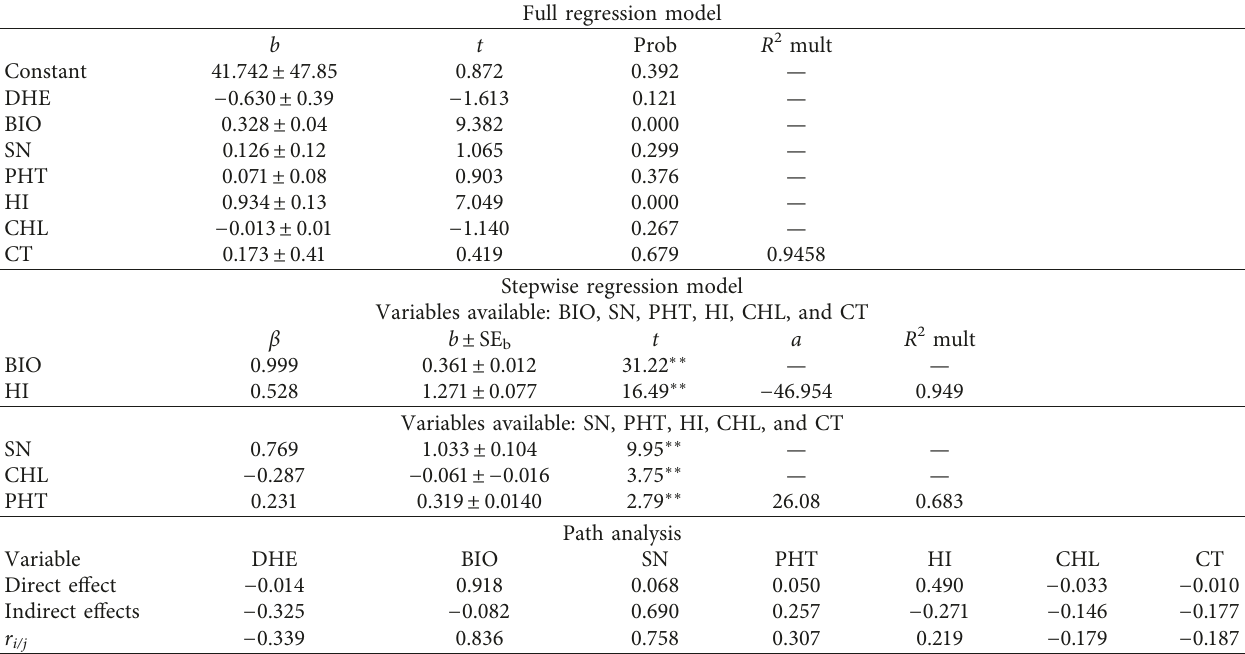
Table 6: Full and stepwise regression models and direct and indirect effects of independent variables on grain yield.